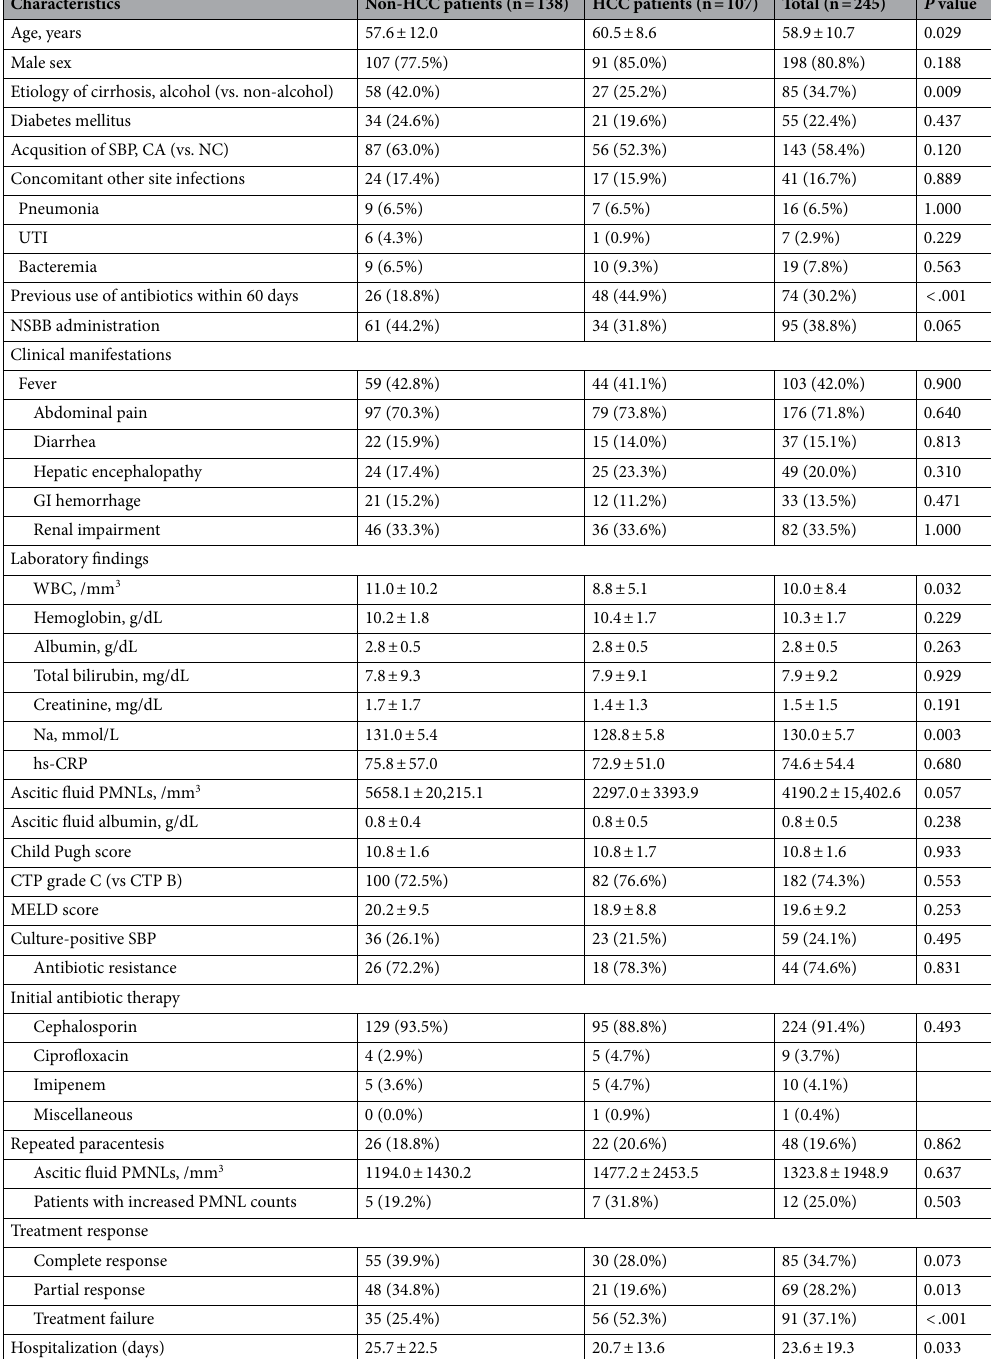
Table 1. Clinical characteristics of patients. Data were expressed as number (percentage) or mean ± standard deviation. CA Community acquired, CRP C-reactive protein, CTP Child Pugh, GI Gasointestinal, NSBB